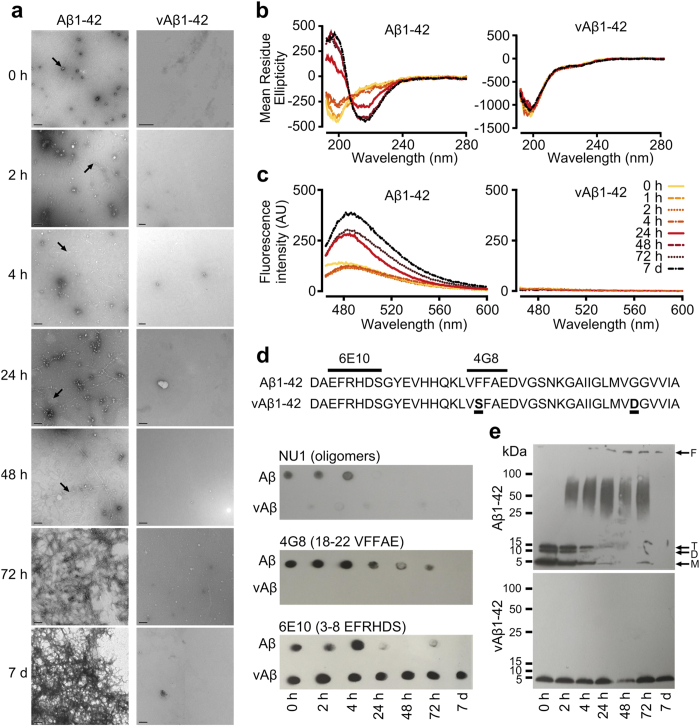
(a) Negative stain transmission electron microscopy images of Aβ1-42 (left panels) and vAβ1-42 peptide (right panels) showing assembly of Aβ1-42 into fibrils at around 24 hours, preceded by small spherical structures (both shown by arrows). Conversely the vAβ1-42 peptide does not form fibres even up to 7 days. All peptides were prepared as described in the methods at 50 μM. Scale bars 200 nm. (b) CD spectra of Aβ1-42 and vAβ1-42 over time showing the formation of β-sheet structures for Aβ1-42 after around 24 hours whilst vAβ1-42 remains as random coil structure up to the final time point of 7 days. (c) Thioflavin T fluorescence showing increasing fluorescence at 483 nm of Aβ1-42 over 7 days, compared to no change in fluorescence of vAβ1-42. (d) Sequence of Aβ1-42 (top) and vAβ1-42 (bottom), showing epitope regions for 4G8 and 6E10 antibodies. The amino acid substitutions are underlined. Dot blots using anti-oligomer antibody, NU1 and anti-Aβ antibodies 4G8 and 6E10 show oligomer reactive species only in Aβ1-42 samples and not vAβ1-42. Similarly, 4G8 does not detect vAβ1-42 due to the F19S substitution in the epitope region. 6E10 binds both Aβ1-42 and vAβ1-42 as the epitope is the same in both peptides. (e) Western blot of Aβ1-42 (top) and vAβ1-42 (bottom) with 6E10 over time shows monomers (M), dimers (D), trimers (T), higher molecular weight species and fibres (F) are only formed by the wild-type peptide. vAβ1-42 runs as a monomer.